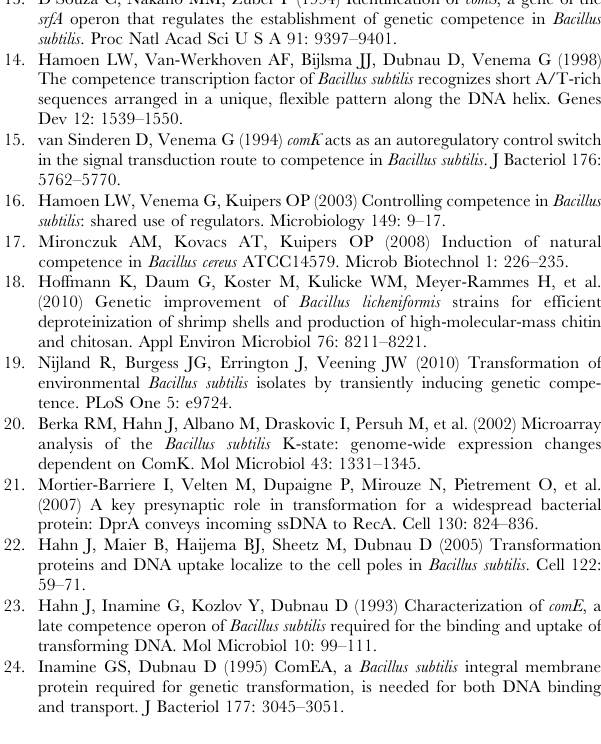
Table S1 Summary of transcriptional changes in B.